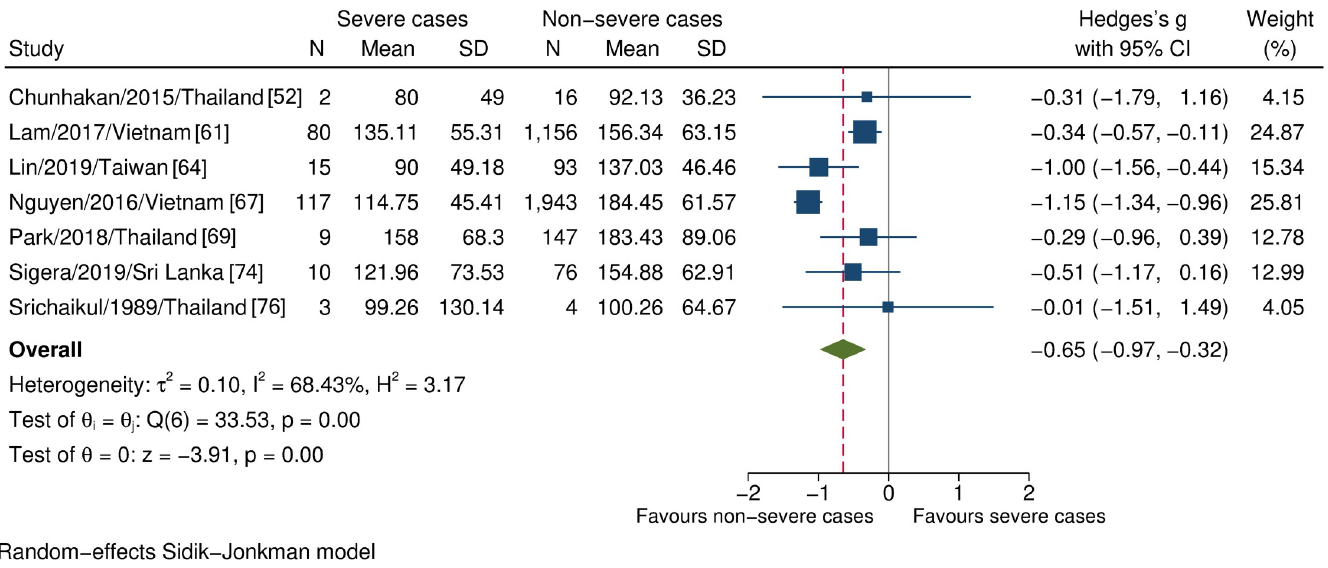
Fig 2. Forest plot showing the relationship between platelet counts and severe dengue. One study was an outlier [67]; the estimated effects remained unaltered after the sensitivity analysis. The red dashed line represented the overall effect